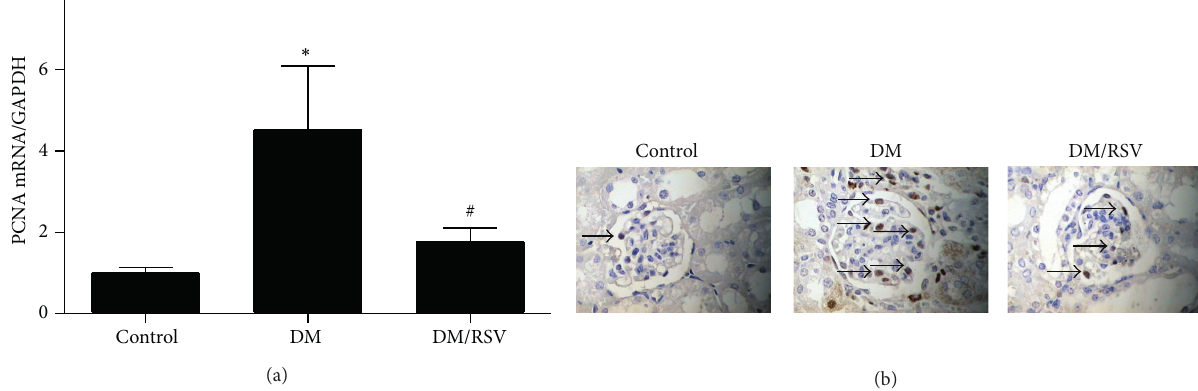
Figure 6: Resveratrol (RSV) protected mice from diabetes-induced mesangial cell proliferation in glomeruli. The proliferating cell nuclear antigen (PCNA) mRNA levels were detected using Real-time PCR (a). The representative images showed PCNA-positive cells (with brown nuclear) in kidney of three groups ( ×400 ) (b). Results represent as mean ± SD. ∗ 𝑃 < 0.05 compared with control group, # 𝑃 < 0.05 compared with diabetes mellitus (DM) group.